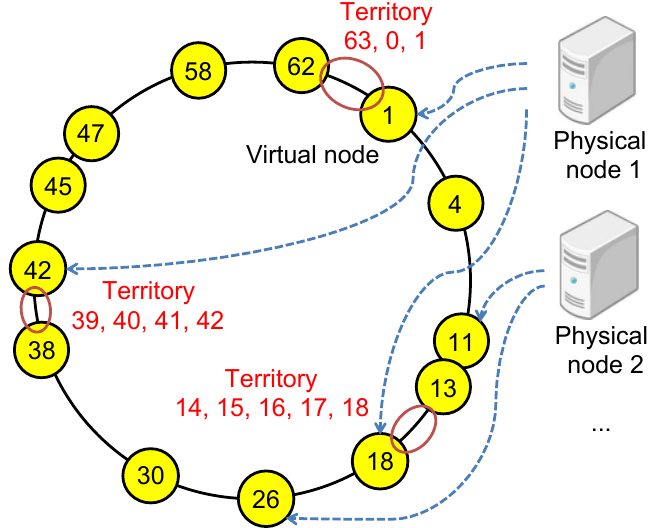
Figure 5. An example of virtual node placement by physical